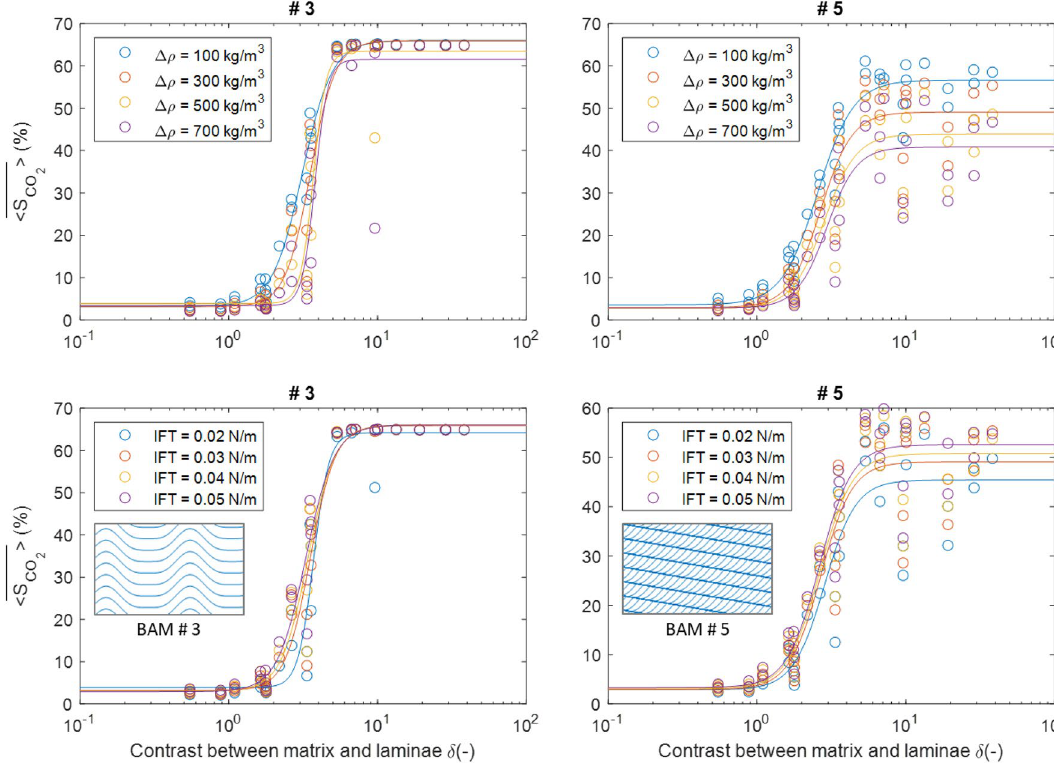
Figure 8. Effects of varying the density difference and the IFT value for two selected BAMs. The inset graphs show the BAM patterns. The fitted models have solid lines with the same color as the data series shown in